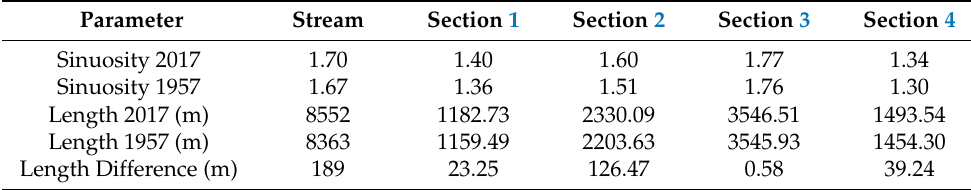
Table 2. Variation in morphometric